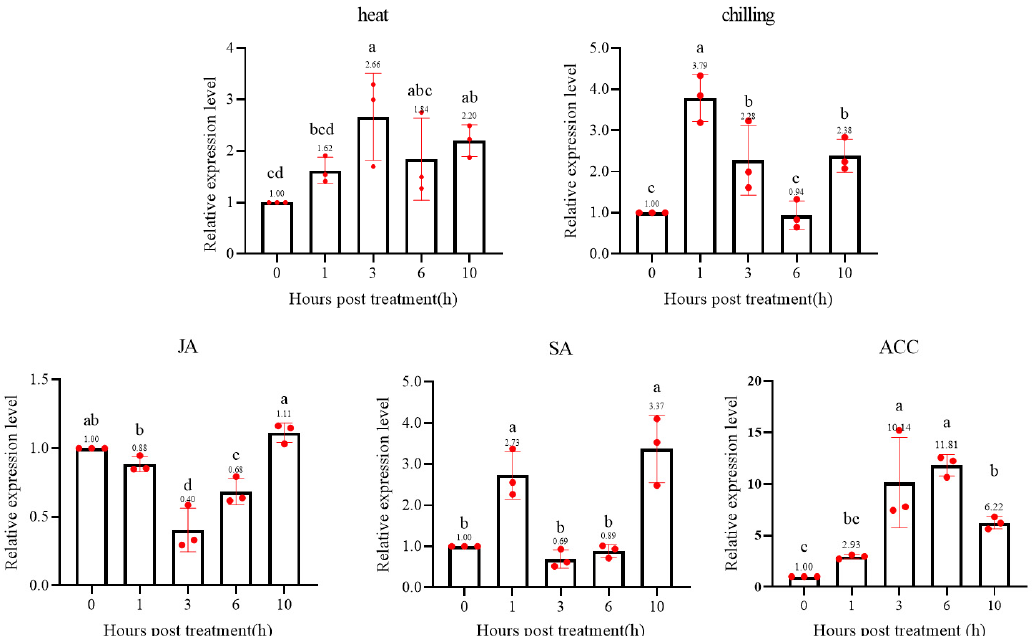
Figure 5. The expression of ShWRKY41 in wild tomato S. habrochaites LA1777 under abiotic stresses. ‘heat’ means a 40 °C high temperature stress, and ‘chilling’ represents a 8 °C low temperature stress. ‘JA’, ‘SA’, and ‘ACC’ mean plant hormones stresses. The different lowercase letters (e.g., a, b, c, etc.) represent the significance at p = 0.05 level, and if there are one or more same letters between different groups (e.g., ab, bc, abc, etc.), it means there is a difference between those groups but not significant.